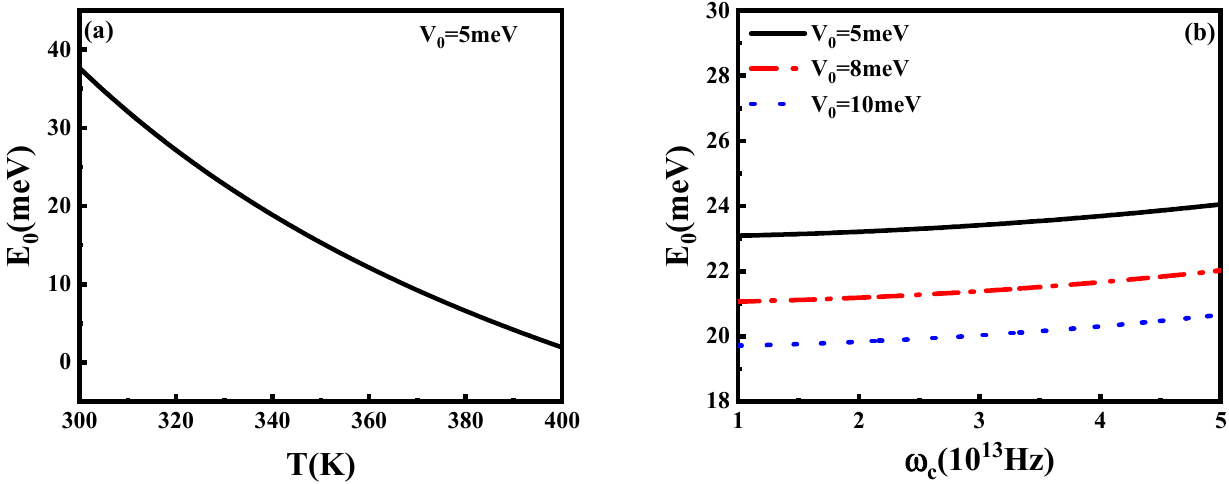
Figure 9. Ground-state energy E 0 ( a ) versus temperature T and ( b ) magnetic field’s cyclotron fre- quency ω c .